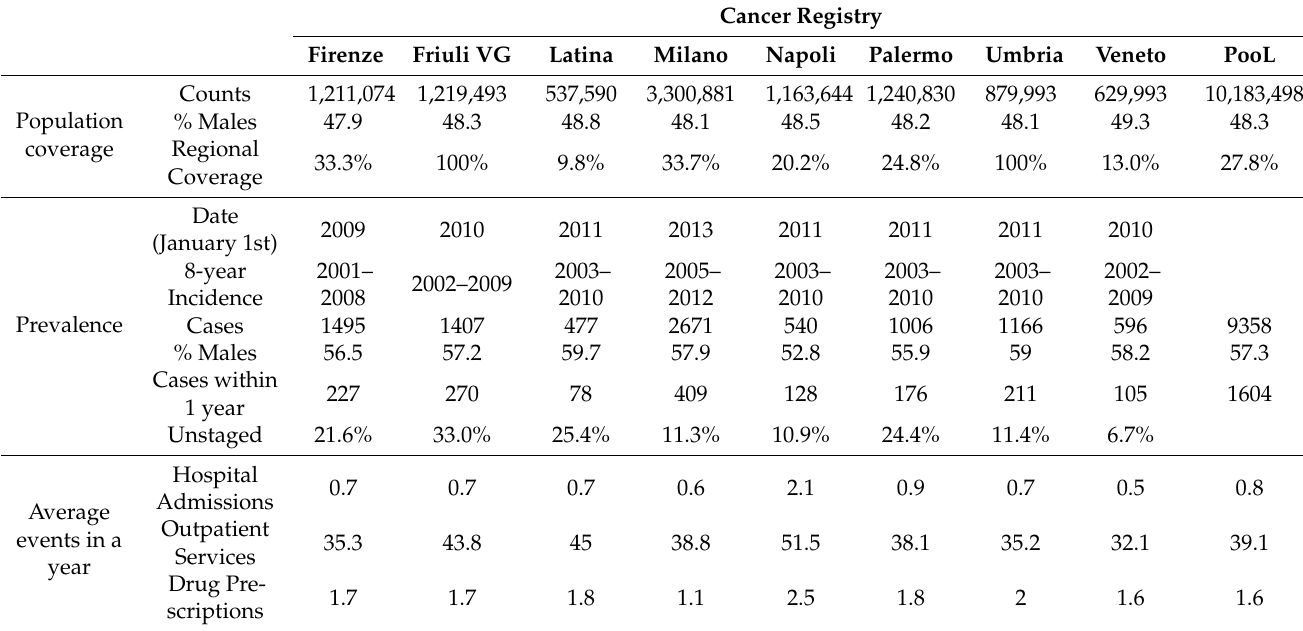
Table 1. Population coverage, Prevalence, Average number of events in a year by Cancer Registry (CR) and in the pool of